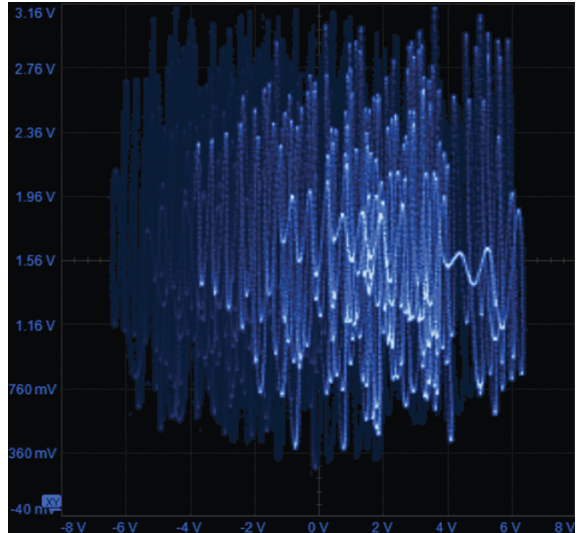
Figure 39: Experimental hyperchaotic attractor of the proposed model (1) in the ( z